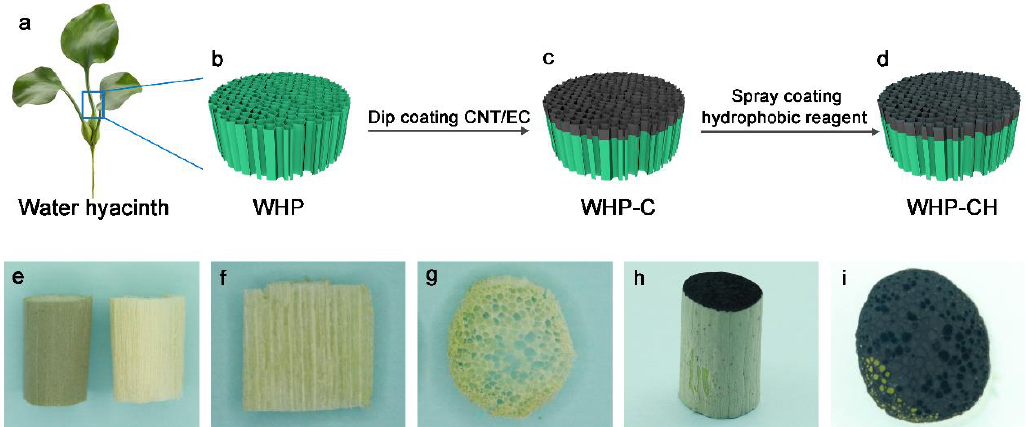
Figure 1. ( a ) Photo of water hyacinth petiole. ( b – d ) Schematic illustration showing the fabrication of WHP-CH. Photos of ( e ) WHP with (left) and without (right) epidermis, ( f ) axial-sectional WHP, ( g ) radial-sectional WHP, ( h ) front-view WHP-C, and ( i ) top-view WHP-CH.